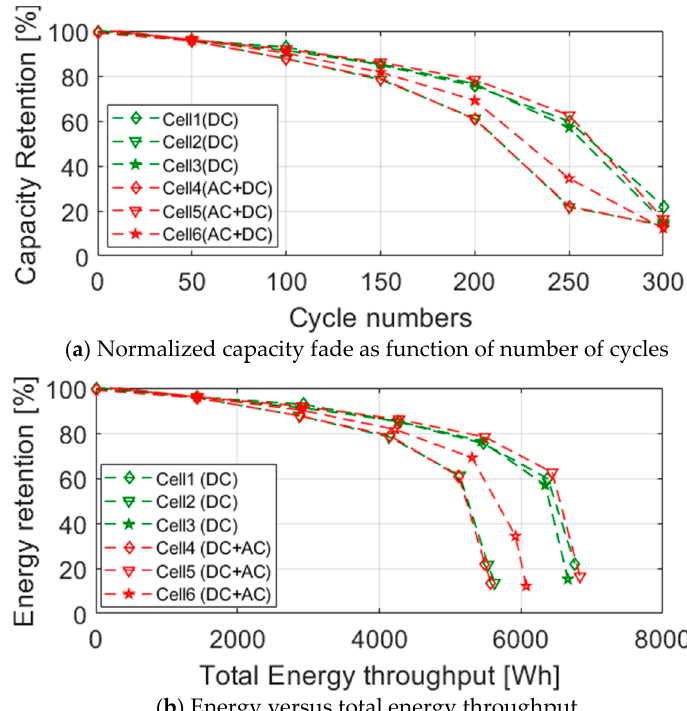
Figure 6. Normalized capacity fade as a function of number of cycles for normal condition group (i.e., cells 1–3) versus AC ripple condition group (i.e., cells 3–5) and retained energy versus total energy throughput.